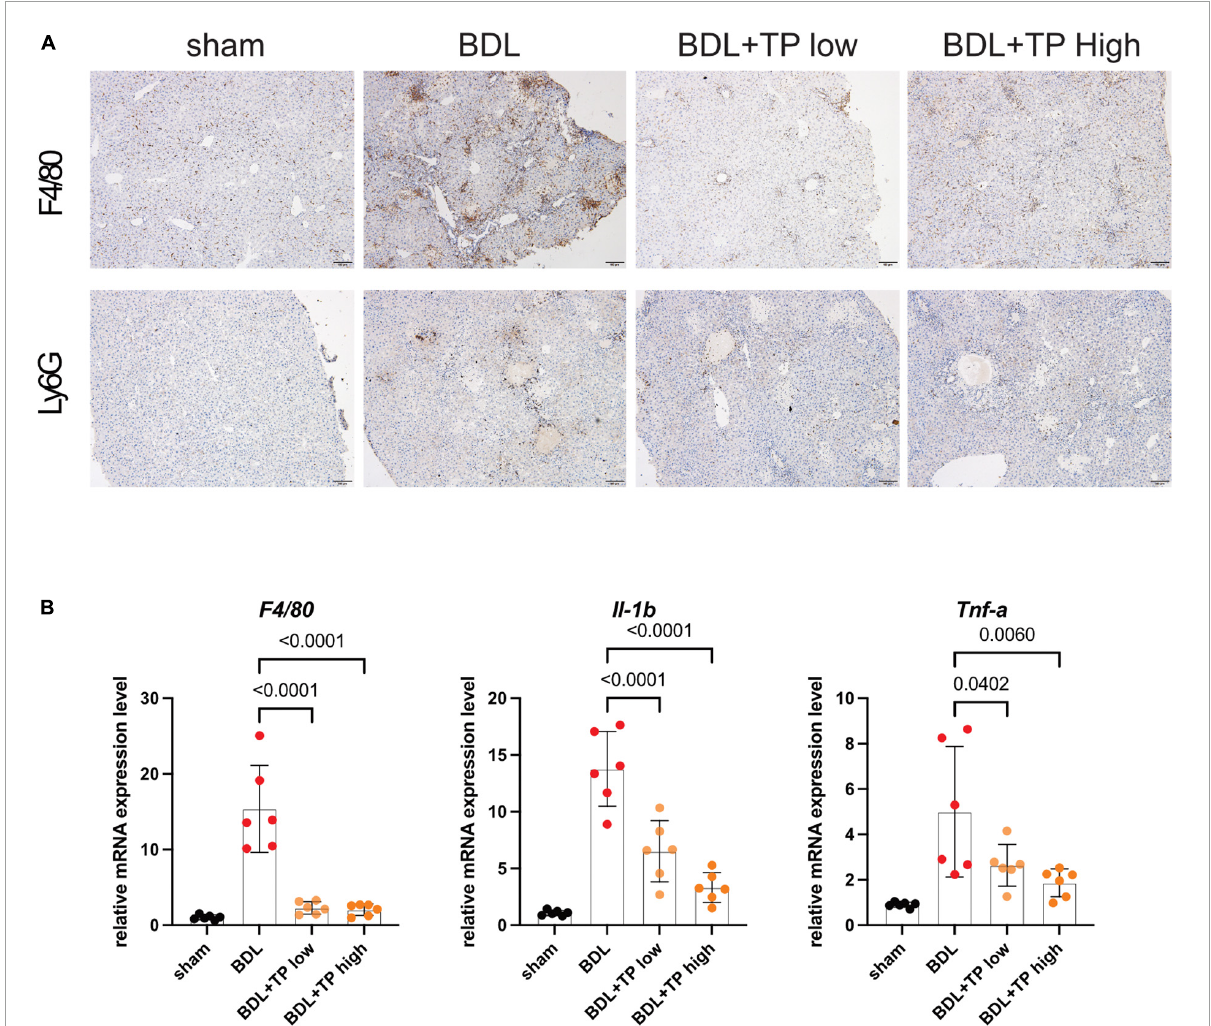
FIGURE6 Triptolide relieves BDL-induced liver inflammation. (A) Representative images of IHC of F4/80 and LY6G from liver tissues. Scale Bar: 100 µ m. (B) The liver mRNA levels of F4/80 , IL-1 β and Tnf- α from liver tissues. Data represent at least 6 independent experiments with triplicate measurements. Analysis of variance (one-way ANOVA) was used. p values represents significance different from BDL